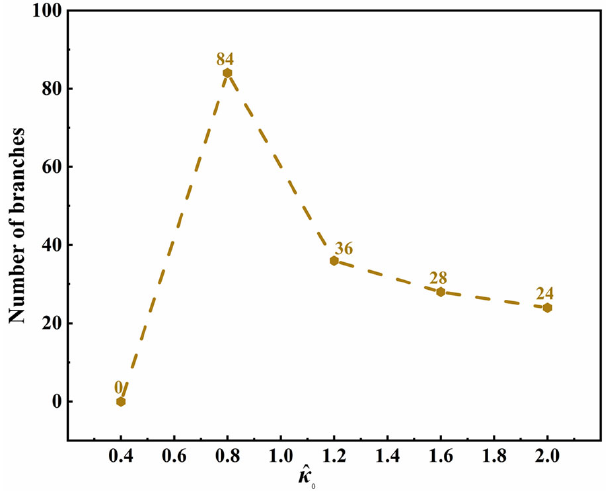
Figure 5. The relationship between the number of branches of a PTFE crystal and interface thickness (anisotropic mode j = 6, evolution of time τ = 160).